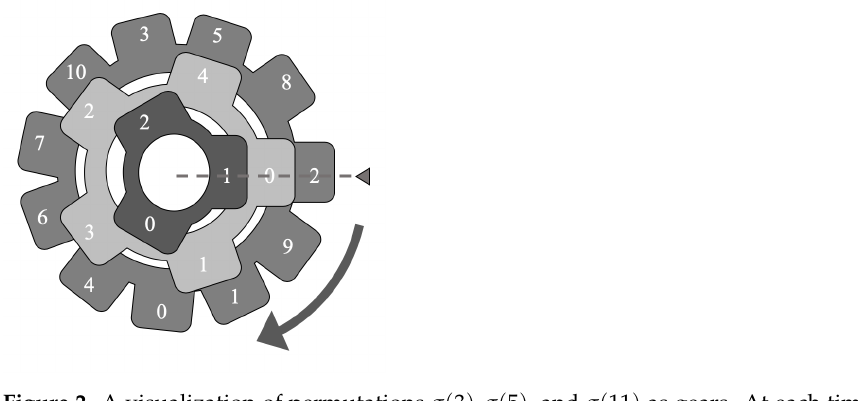
Figure 2. A visualization of permutations σ ( 3 ) , σ ( 5 ) , and σ ( 11 ) as gears. At each time increment, the gears turn clockwise by one tooth. After M = 165 iterations, the initial value (2,0,1)